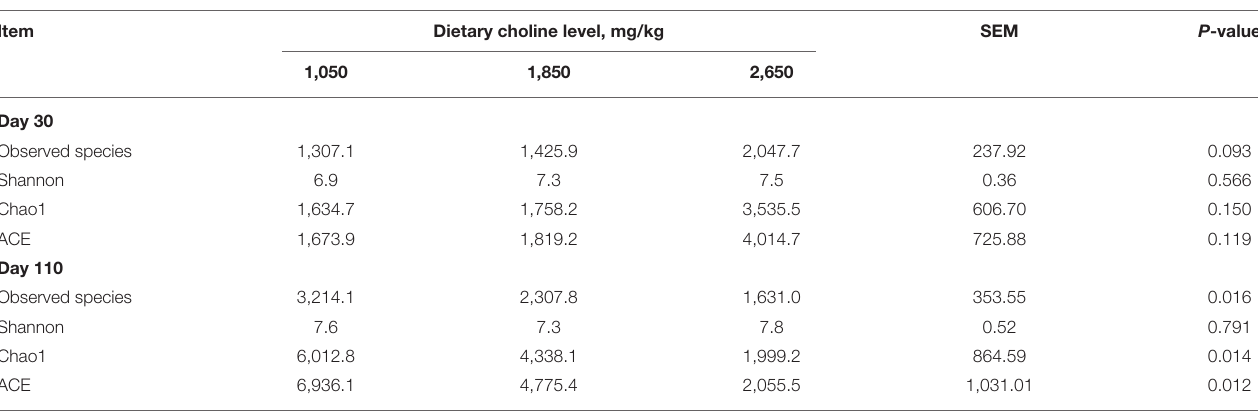
FIGURE 7 | Venn diagram showing the unique and shared OTUs in the different groups at day 30 of gestation (A) and day 110 of gestation (B) . N = 8 for each treatment. TABLE 6 | Differences in bacterial community diversity and richness among the three